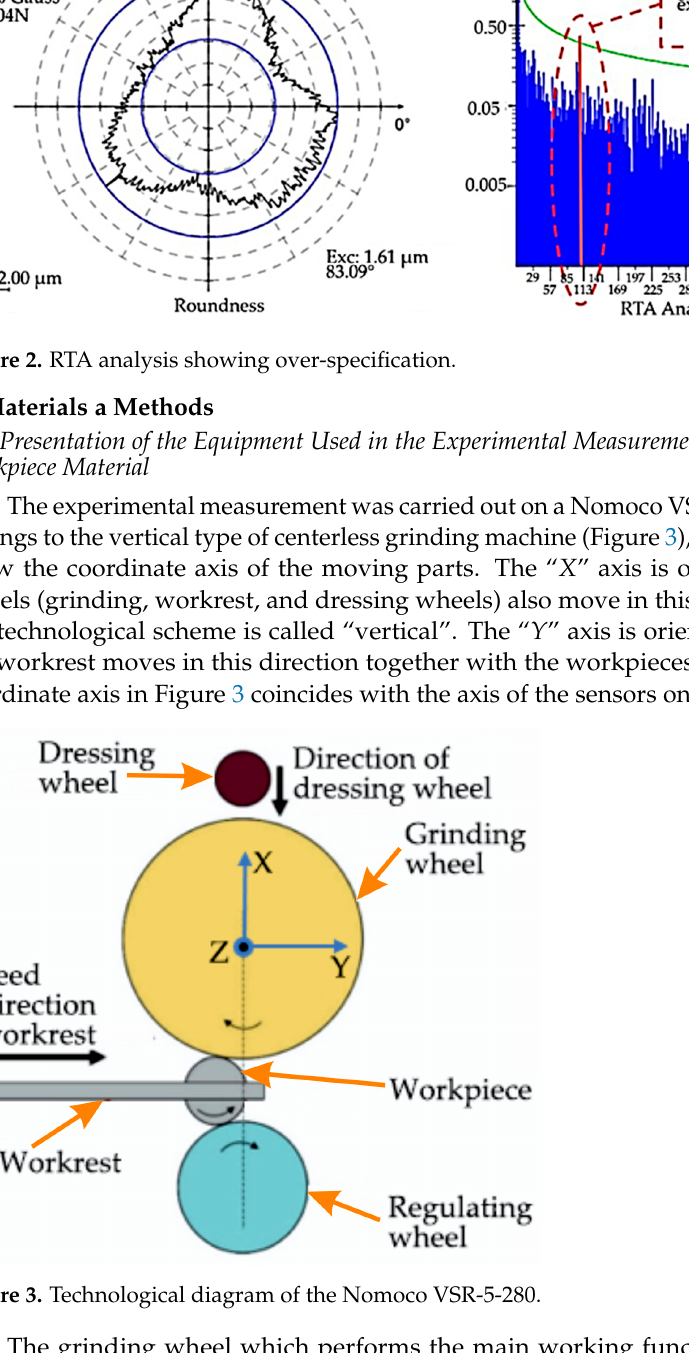
Figure 3. Technological diagram of the Nomoco VSR ‐ 5 ‐ 280.